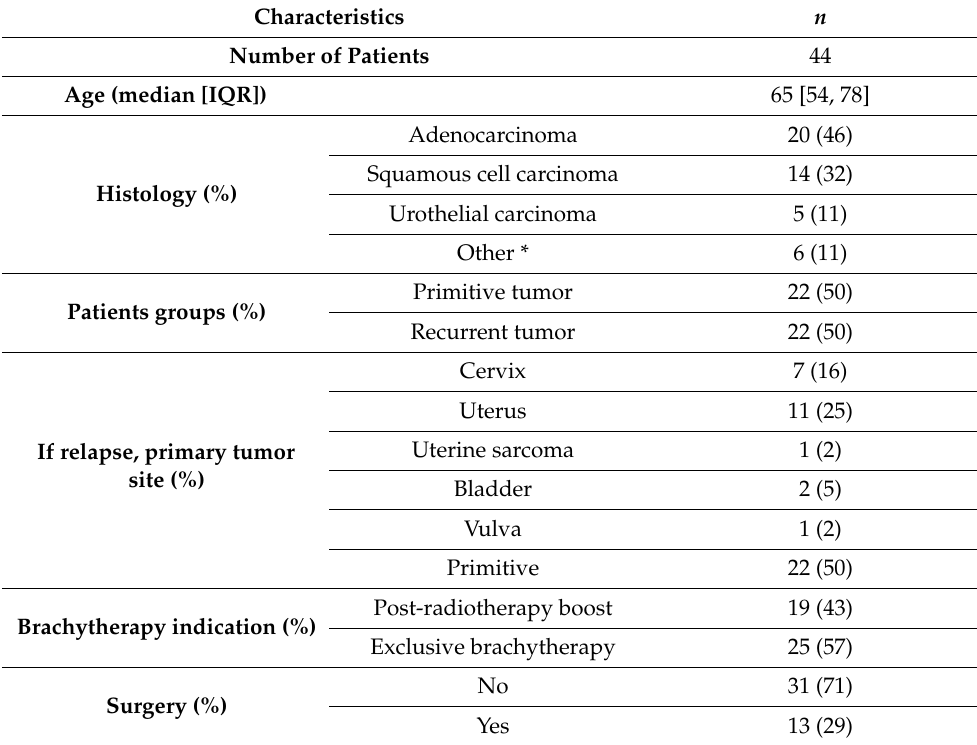
Table 1. Tumors’ characteristics and treatment clinical